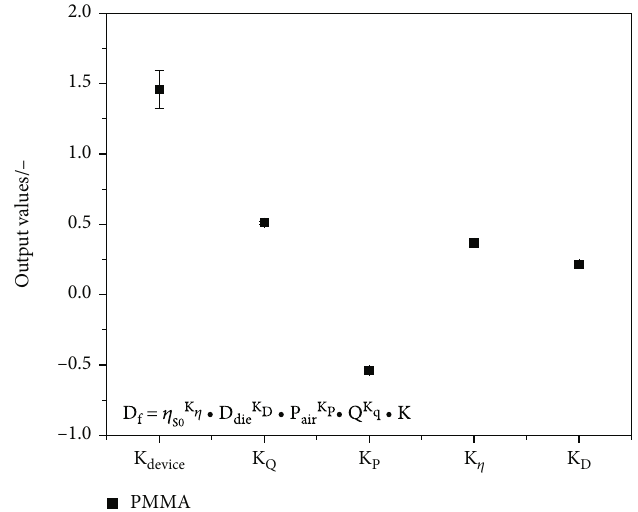
Figure 6: Parameters to predict the fi bre diameter of PMMA using the capillary rheometer combined with an